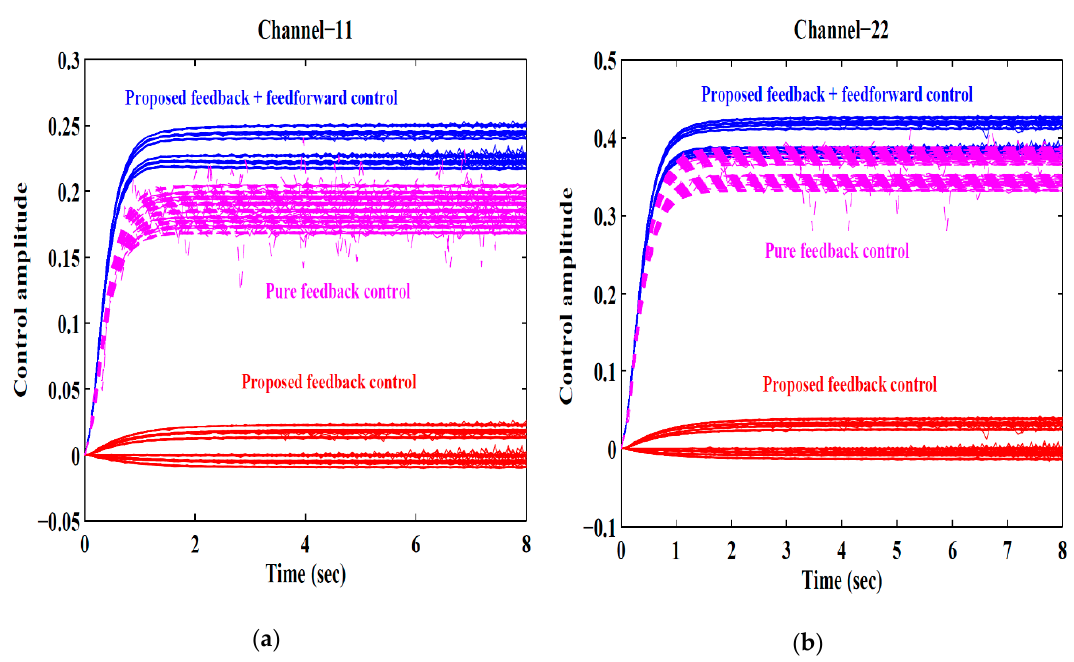
Figure 9. Comparison of control actions (6561 plants) in time domain under unit step input for pure feedback and proposed designs; ( a ) channel-11, ( b ) channel-22.